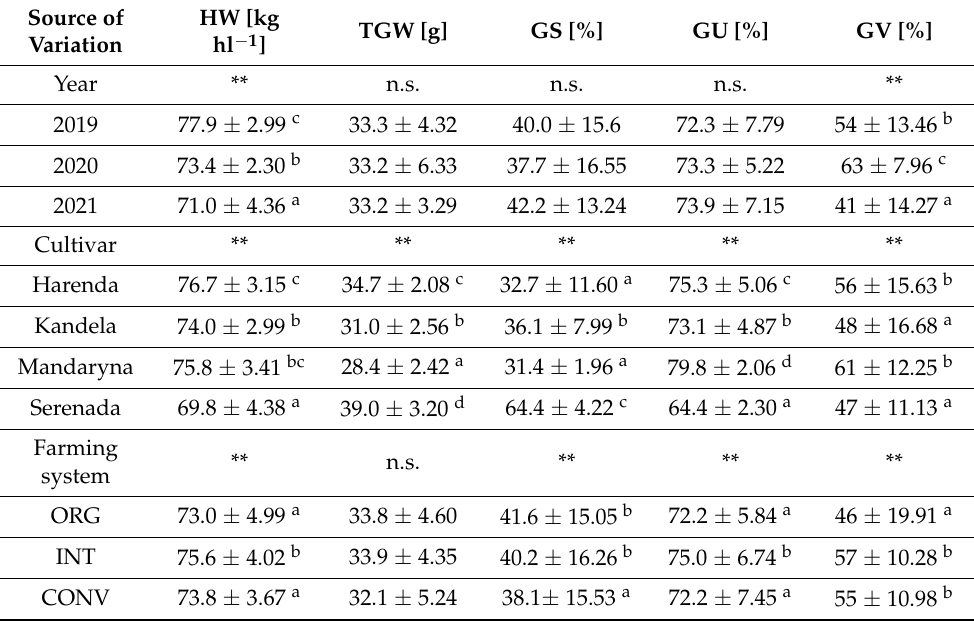
Table 1. The effect of year, cultivar, and farming system on the physical properties of grain. Source